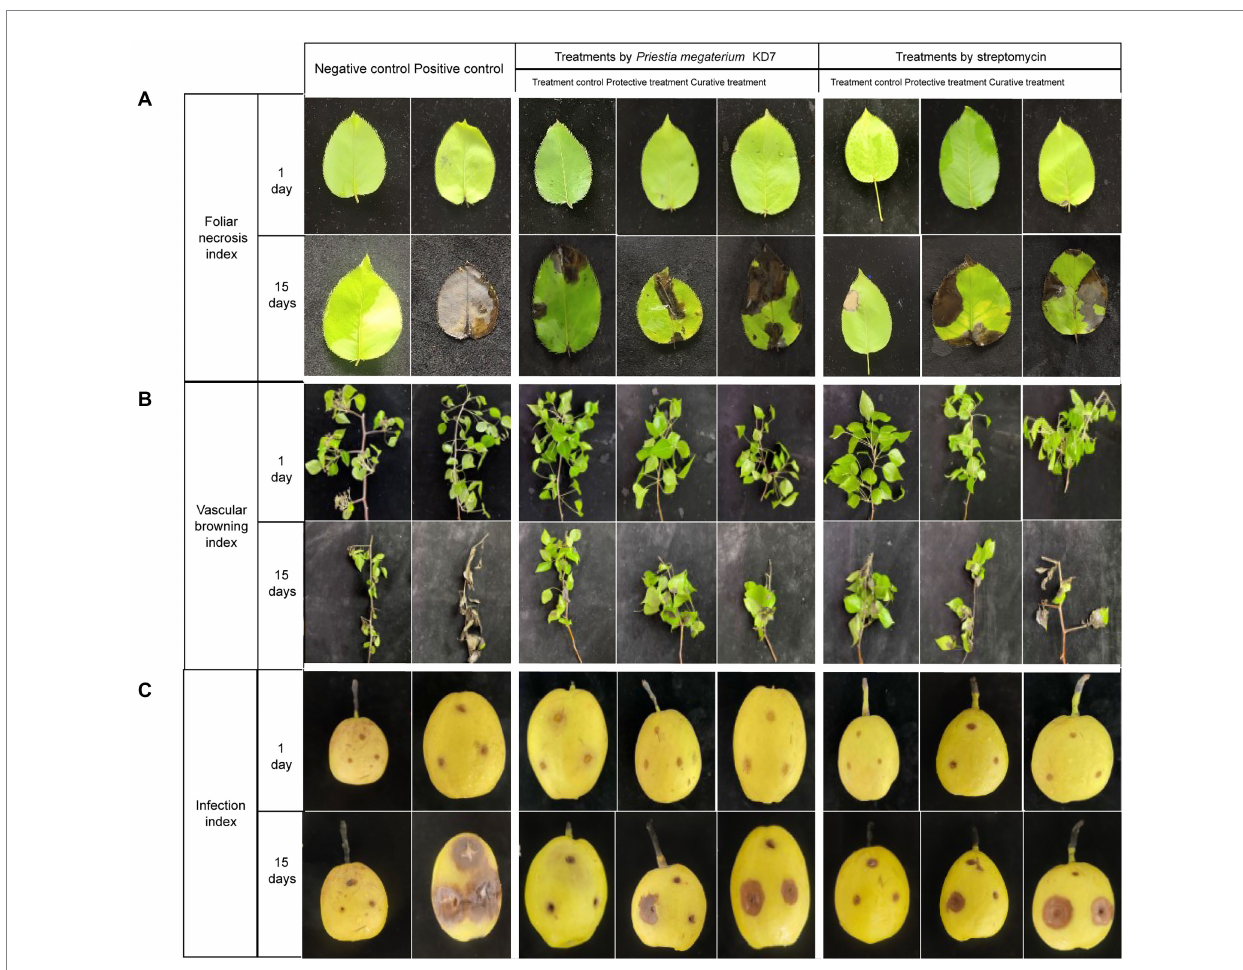
FIGURE 5 Protective and curative effect of P. megaterium strain KD7 against Erwinia amylovora on detached pear leaves (A) , twigs (B) and fruits (C) after 15 days post-inoculation (dpi). The leaves and twigs were collected from wildtype ‘duli’ pear, and fruits from Korla fragrant